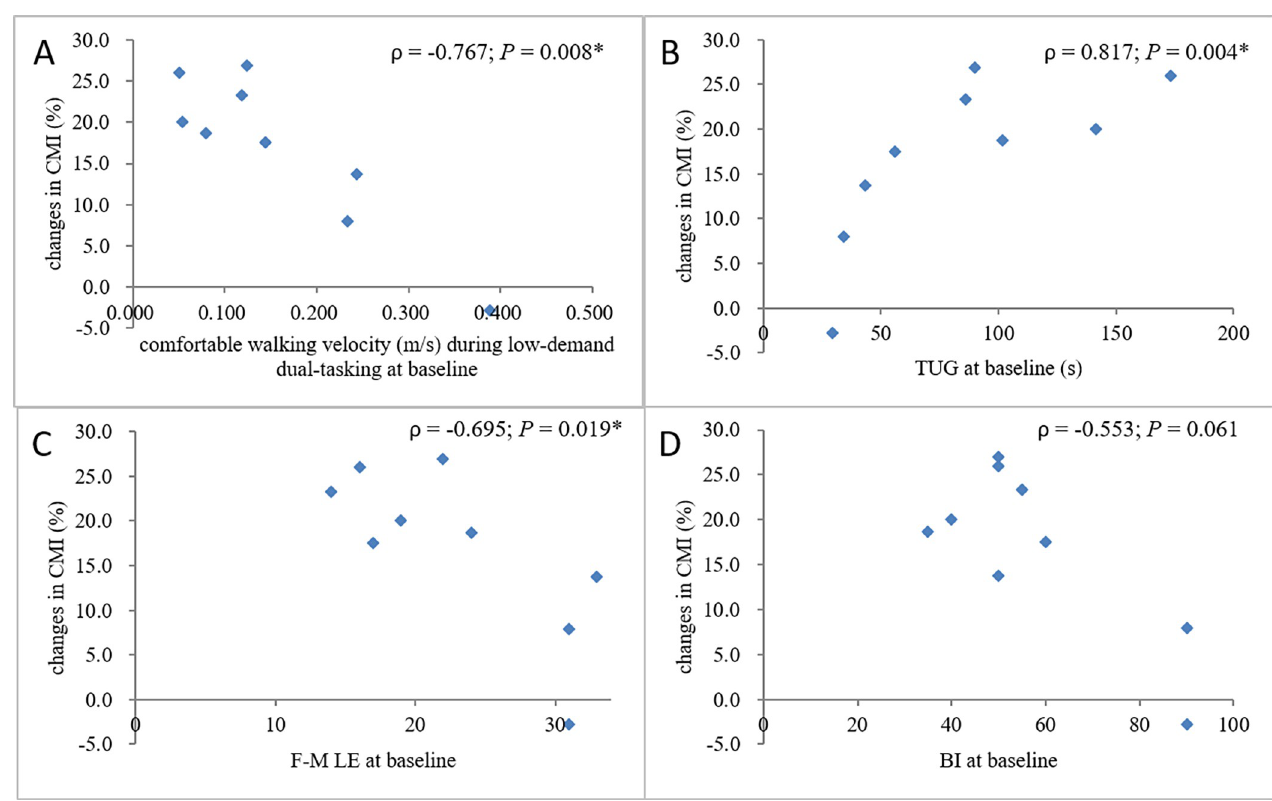
Fig 4. Scatter plots showing the relationship between the change in walking velocity CMI between the baseline and final sessions and (A) comfortable walking velocity during low-demand dual-tasking, (B) the Timed Up and Go test, (C) the lower extremity part of the Fugl-Meyer Assessment, and (D) the Barthel index. A positive CMI value indicated deterioration due to dual-tasking. The results of the Spearman correlation tests are shown.